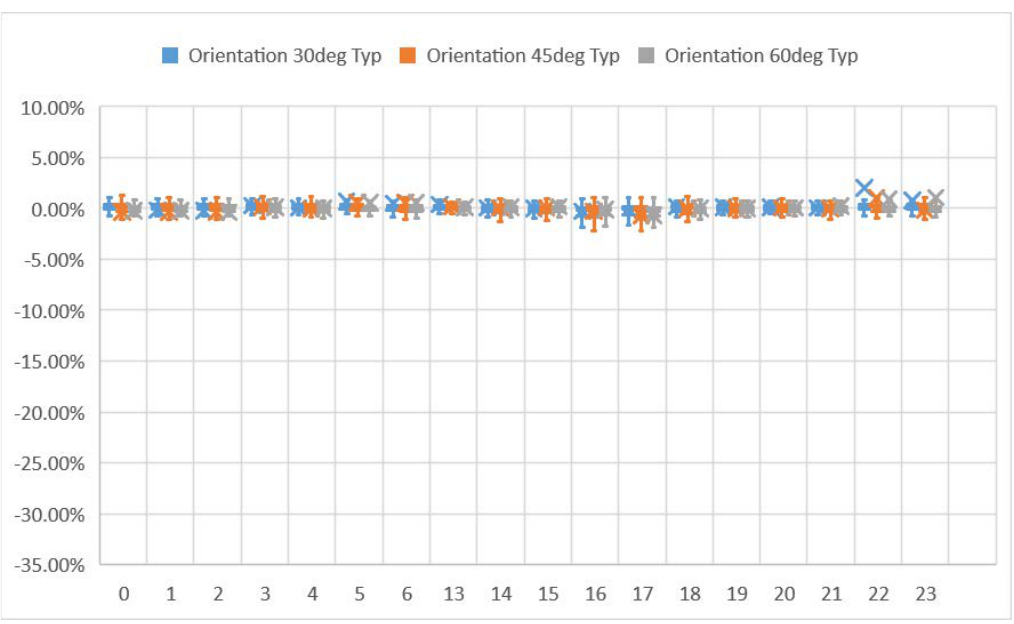
( b ) Box charts for hourly percentage difference in a year for tests for a Typical Floor, (1) Low-E 6 mm glazing; (2) Low-E 6 mm Spec Sel. Appl. Sci. 2020 , 10 , x FOR PEER REVIEW